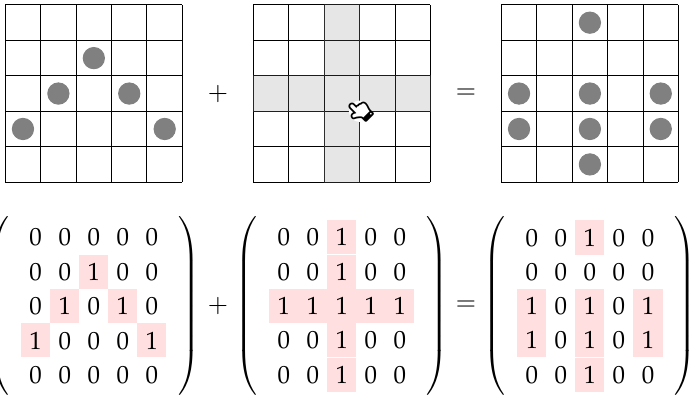
Figure 4. An example of the matrix